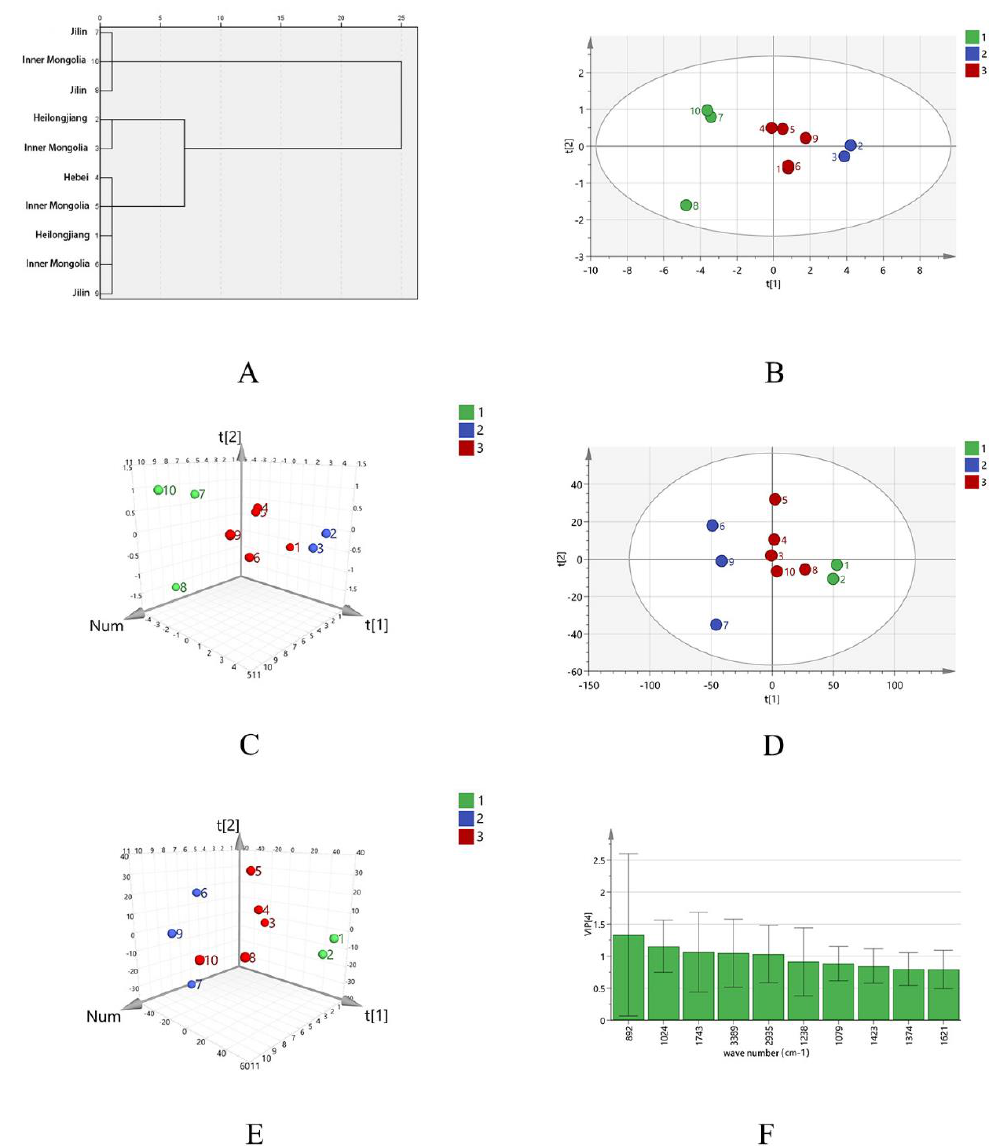
Figure 6. The dengrogram ( A ), the PCA score plot ( B ) and loading plot ( C ) of FT-IR fingerprints of different SPs. The PLS-DA score plot ( D ), loading plot ( E ), and the VIP predicted value plot ( F ) of FT-IR fingerprints of different SPs.